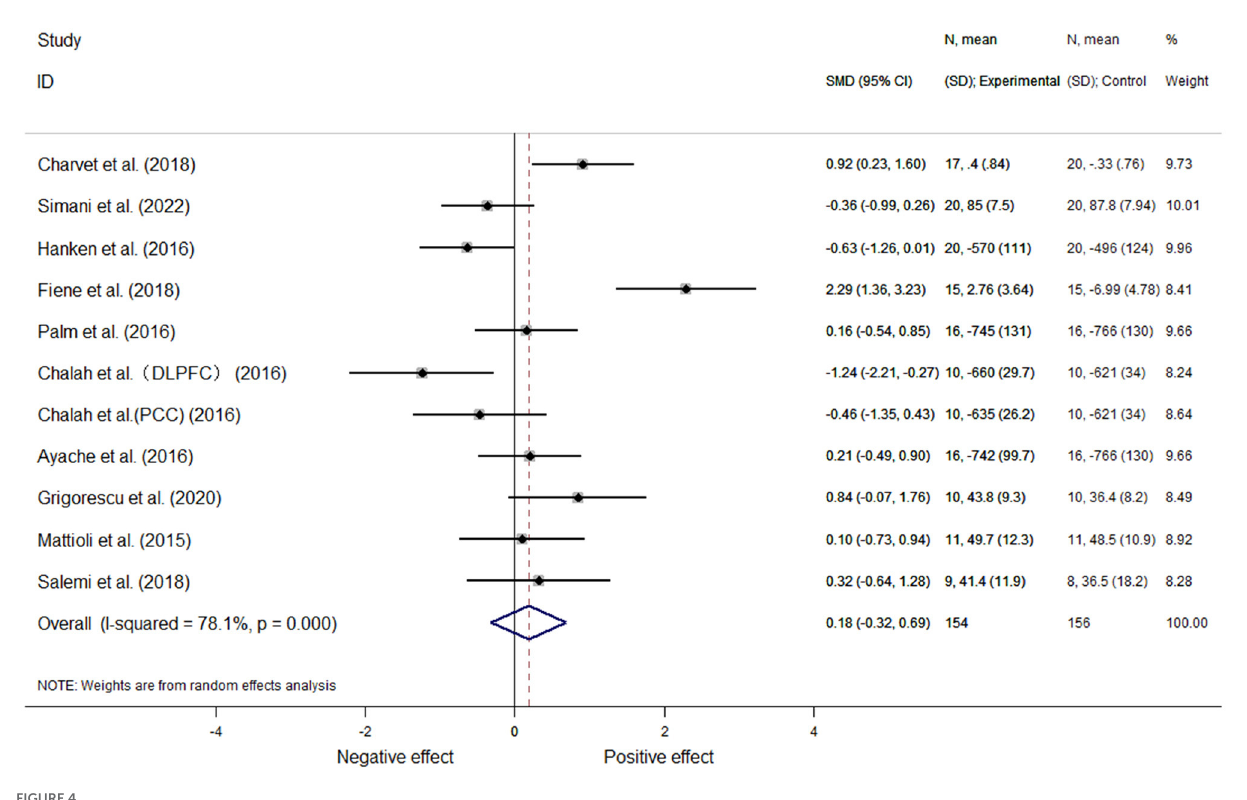
FIGURE4 Cognitive